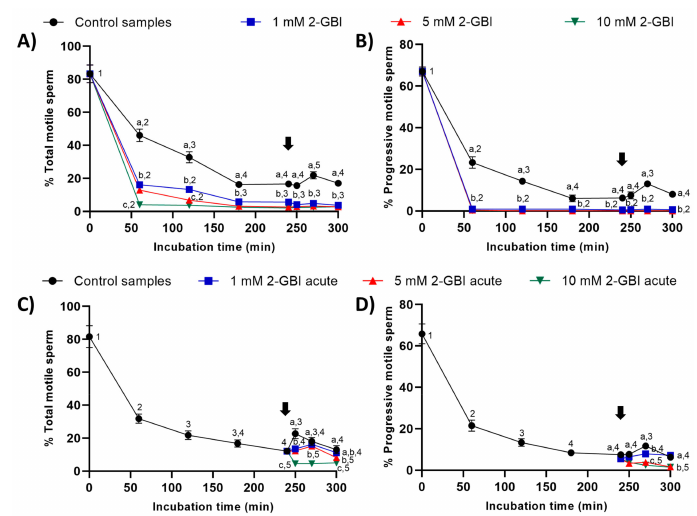
Figure 2. Percentages of total and progressively motile sperm throughout the incubation in capacitating medium (control samples) and capacitating medium plus 1 mM, 5 mM or 10 mM 2-GBI. 2-GBI blocker was added to capacitating medium either at 0 min in experiment 1 ( A , B ) or at 240 min in experiment 2 ( C , D ; acute). Di ff erent superscript letters (a–c) indicate significant di ff erences ( p < 0.05) between treatments within the same time point, and di ff erent superscript numbers (1–5) indicate significant di ff erences ( p < 0.05) between time points within a given treatment. Results are expressed as mean ± standard error of the mean (SEM) ( n = 10). The arrow indicates the time at which 10 µ g / mL of progesterone was added to all samples (i.e., 240 min of incubation).